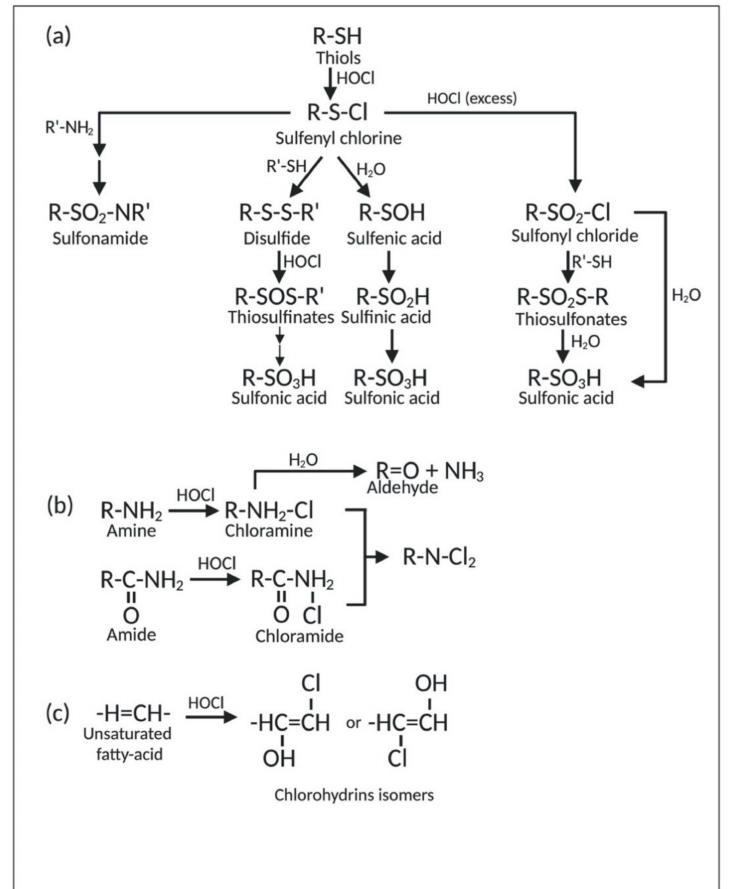
Figure 3. Reaction of HOCl with ( a ) thiol-containing compounds, ( b ) amine and amide, and ( c ) unsaturated fatty